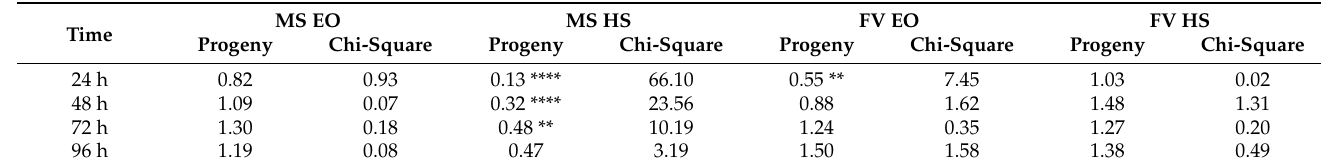
Table 3. Results of daily progeny production assessment of A. gossypii adults exposed to M. suaveolens and F. vulgare EOs and HSs. Twenty replicates were carried out, and 10 adults were used per replicate (N = 200). MS EO = M. suaveolens essential oil; MS HS = M. suaveolens hydrosol; FV EO = F. vulgare essential oil; FV HS = F. vulgare hydrosol. Progeny is expressed as the number of offspring per adult for each treatment; Chi-square values and significance of differences reported are based on Chi-square tests for each treatment vs. untreated control. Significance is expressed as ** = p < 0.01; **** = p <